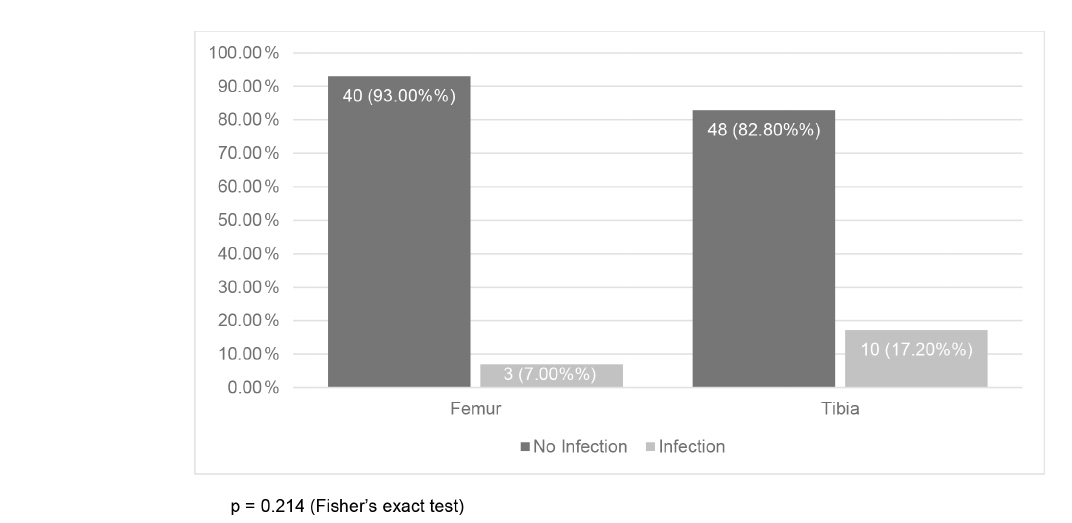
Figure 1. Association between fracture bone nailed and infection ( N = 101). p = 0 . 214 (Fisher’s exact test).